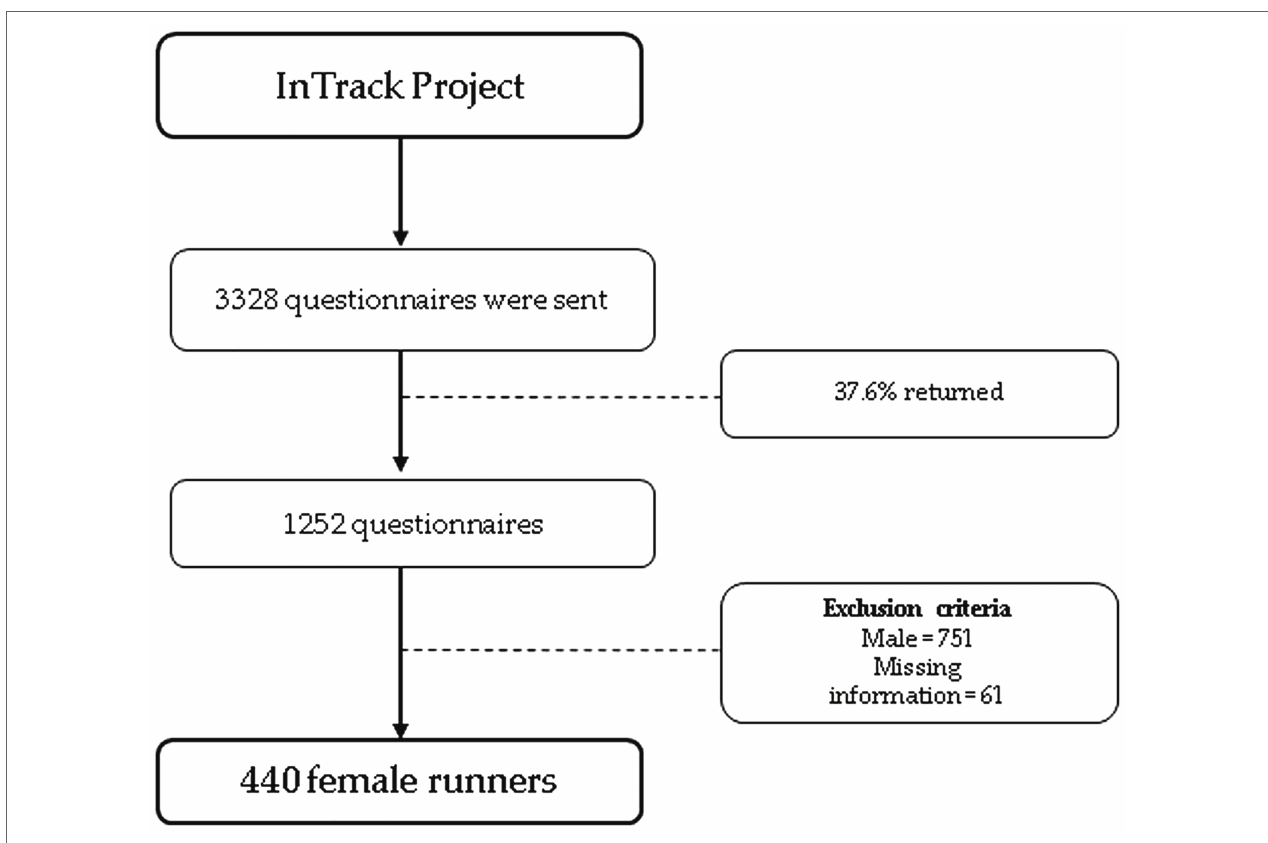
FIGURE 1 | Flow chart of sampling